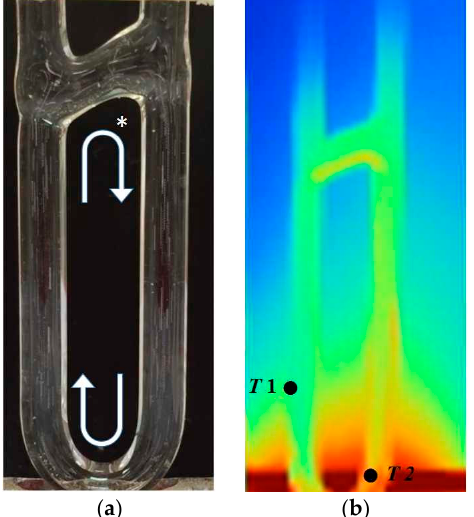
Figure 2. ( a ) Flow observation when heating the bottom of the glass capillary loop (overlaying 20 frames per second and exposing for one second). * the solution flows clockwise; ( b ) Temperature measurement with an IR thermometer (the T 2 average temperature is 94.6 °C with a maximum value of 96.0 °C, and a minimum value 93.3 °C; the T 1 average temperature is 66.7 °C with a maximum value of 68.7 °C, and a minimum value 63.8 °C). and a minimum value 63.8 ◦